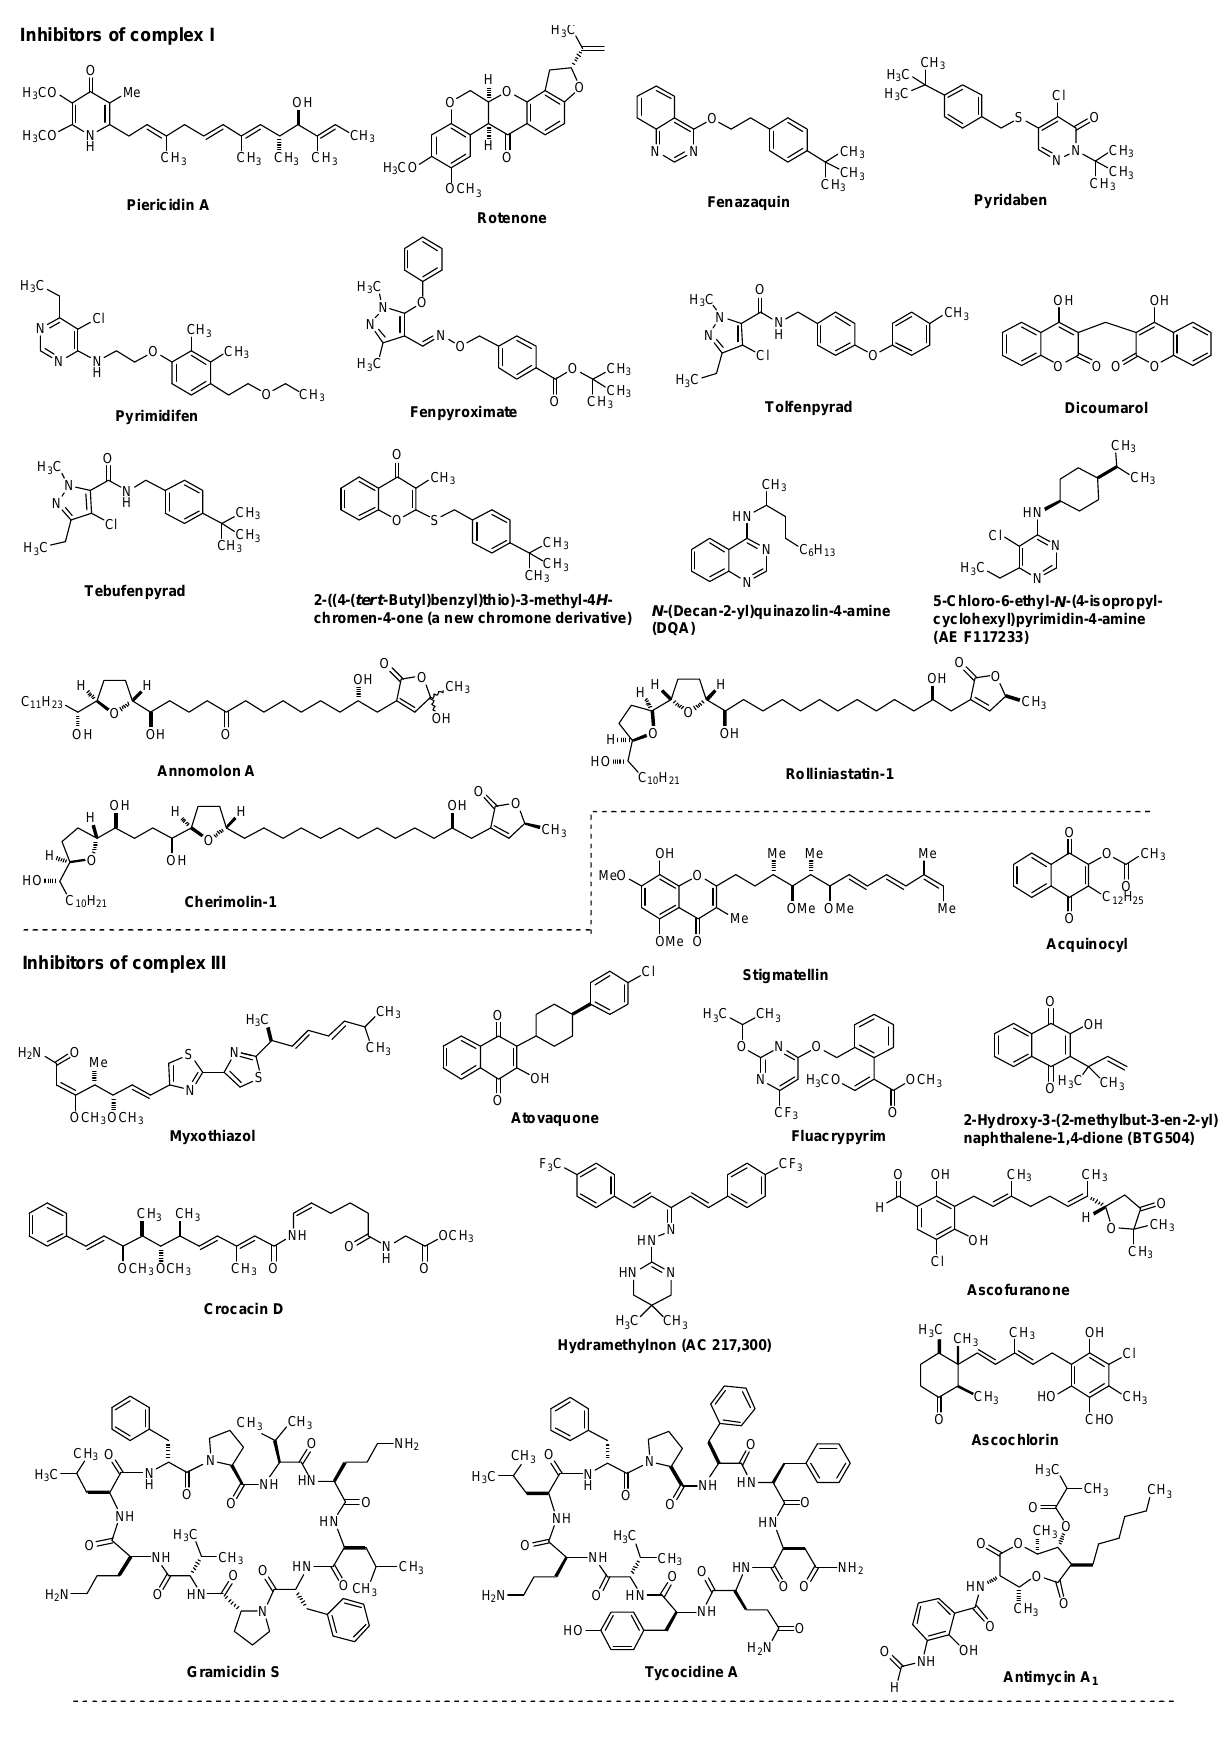
Figure 7. Representative known respiration